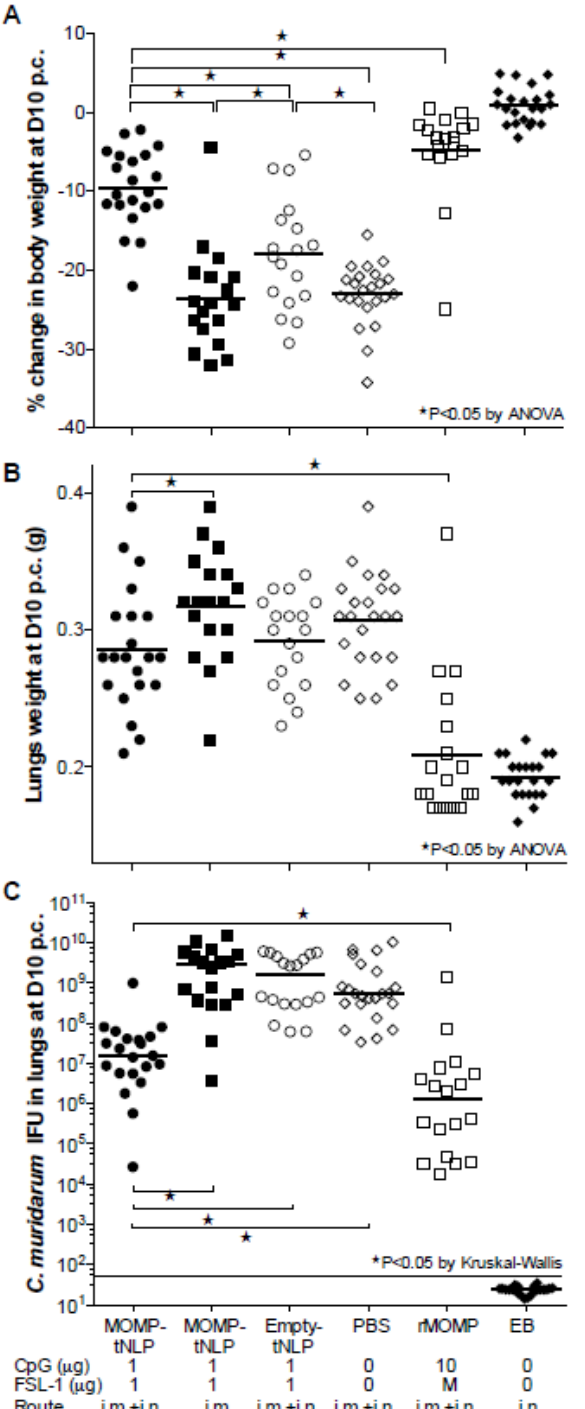
Figure 5. Systemic and local disease burden following the i.n. challenge with C. muridarum . ( A ) Per- centage change in mean body weight at D10 following the i.n. challenge. The mean is shown as a horizontal line. Each symbol represents a single animal. ( B ) Lungs weight (g) at D10 after the i.n. challenge. The mean is shown as a horizontal line. Each symbol represents a single animal. ( C ) Number of C. muridarum IFU recovered from the lungs at D10 after the i.n. challenge. The median is shown as a horizontal line. Each symbol represents a single animal. * p <